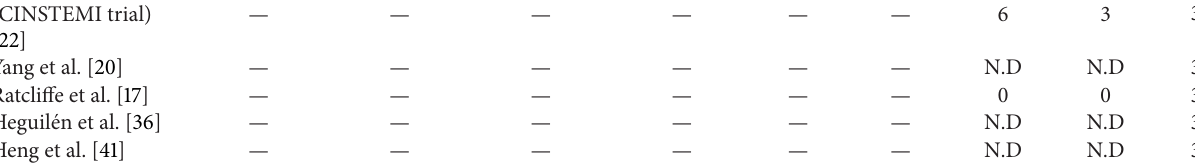
(Table 1). Pooled analysis indicated that SB versus SC